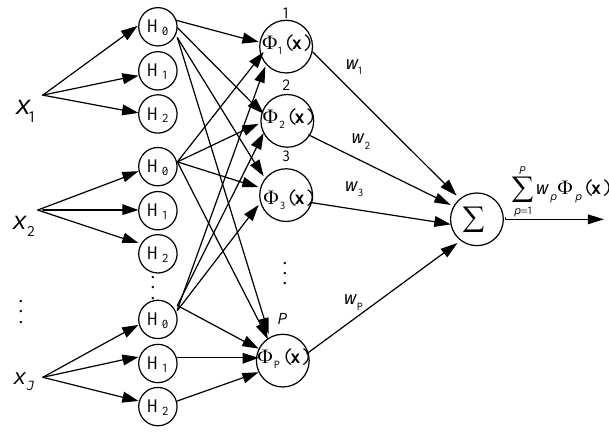
Figure 1. Framework of a PCE with second-order chaos polynomial factor.